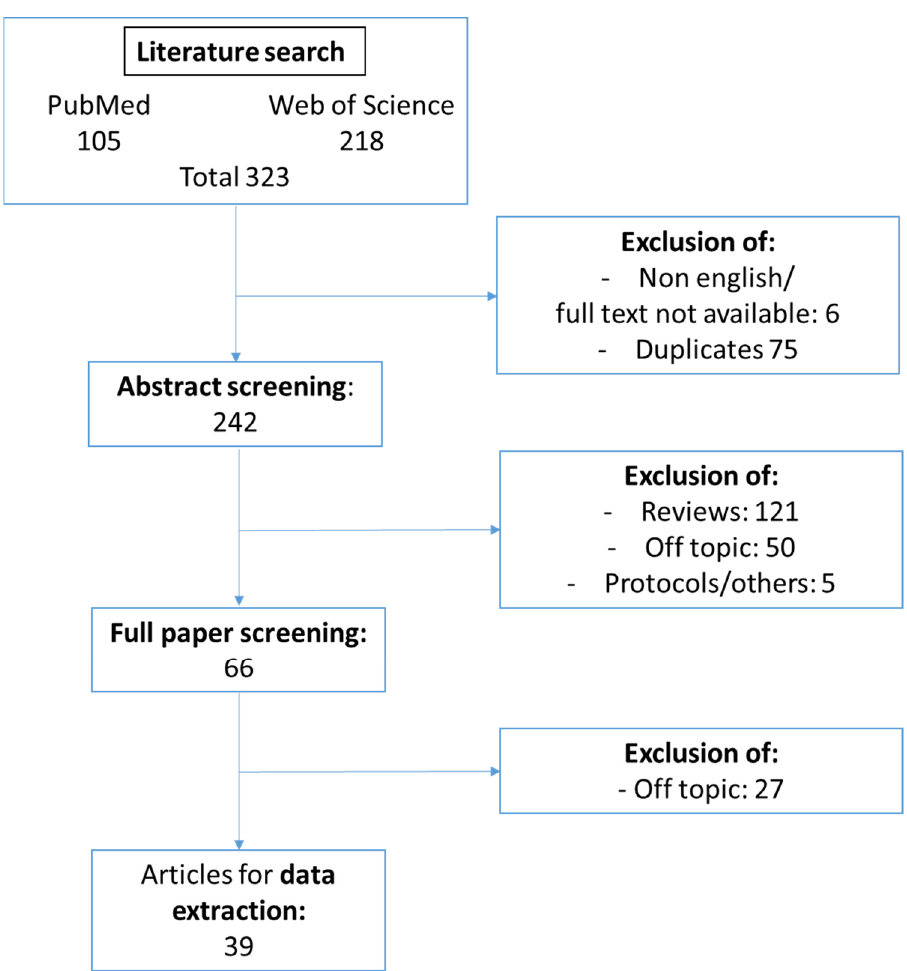
Figure 2. Flow diagram of study selection. Flow diagram of the selection of original papers illustrating the number of in- and excluded studies throughout the selection process.